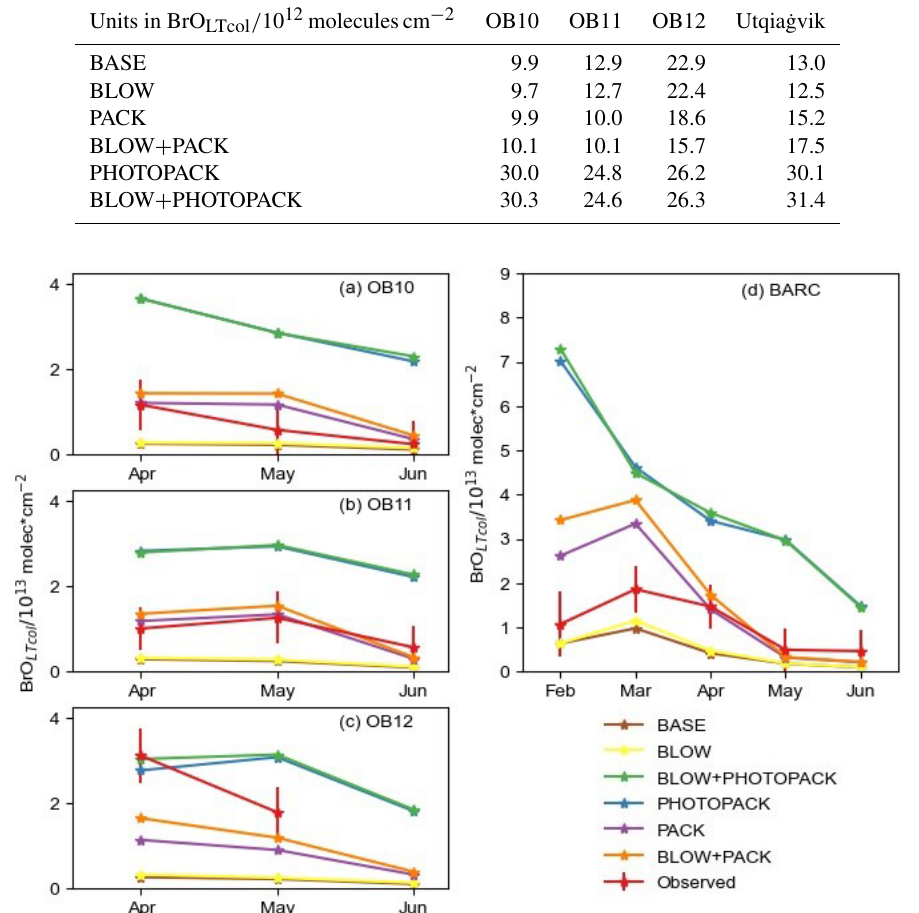
Table 2. Model root mean square error by run and location. Root mean squared model error (RMSE) shown in BrO LTcol / 10 12 moleculescm − 2 RMSE calculated as the square root of the mean of the squared errors for all times with valid observed BrO LTcol in spring 2015.